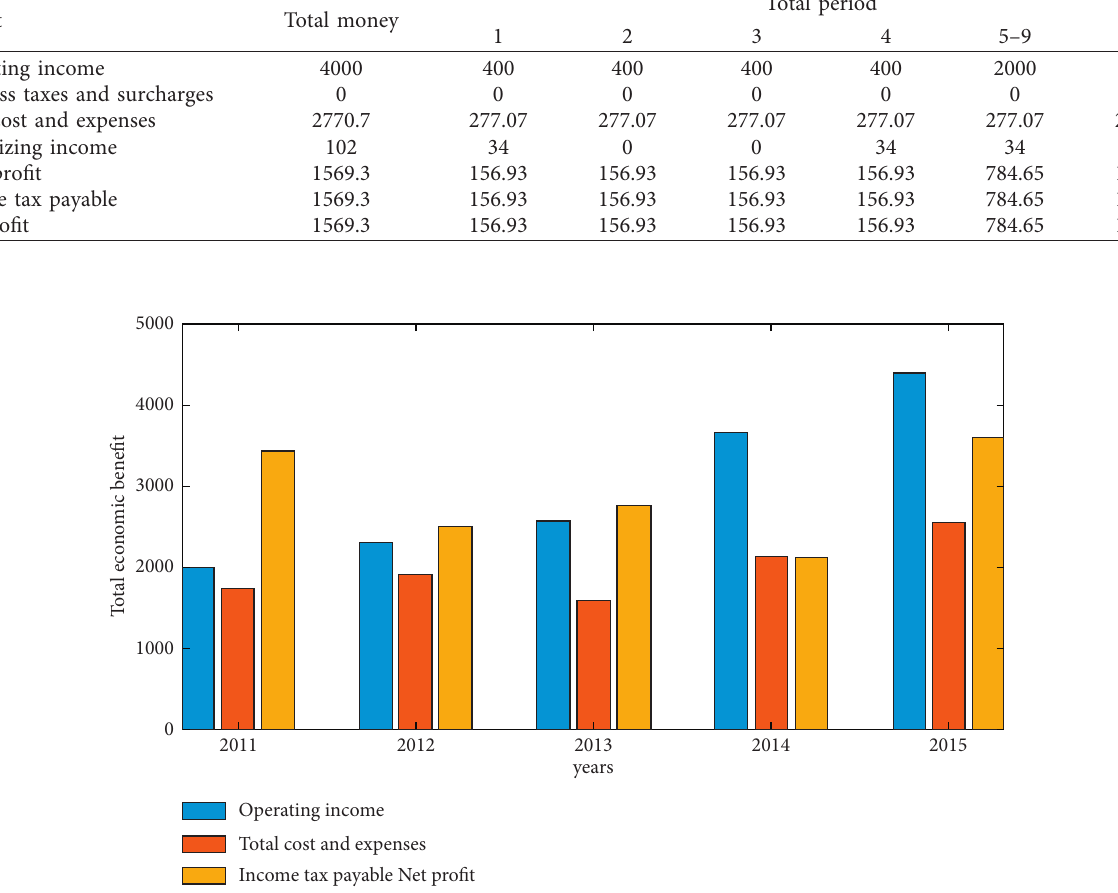
Figure 4: Schematic diagrams of economic benefit